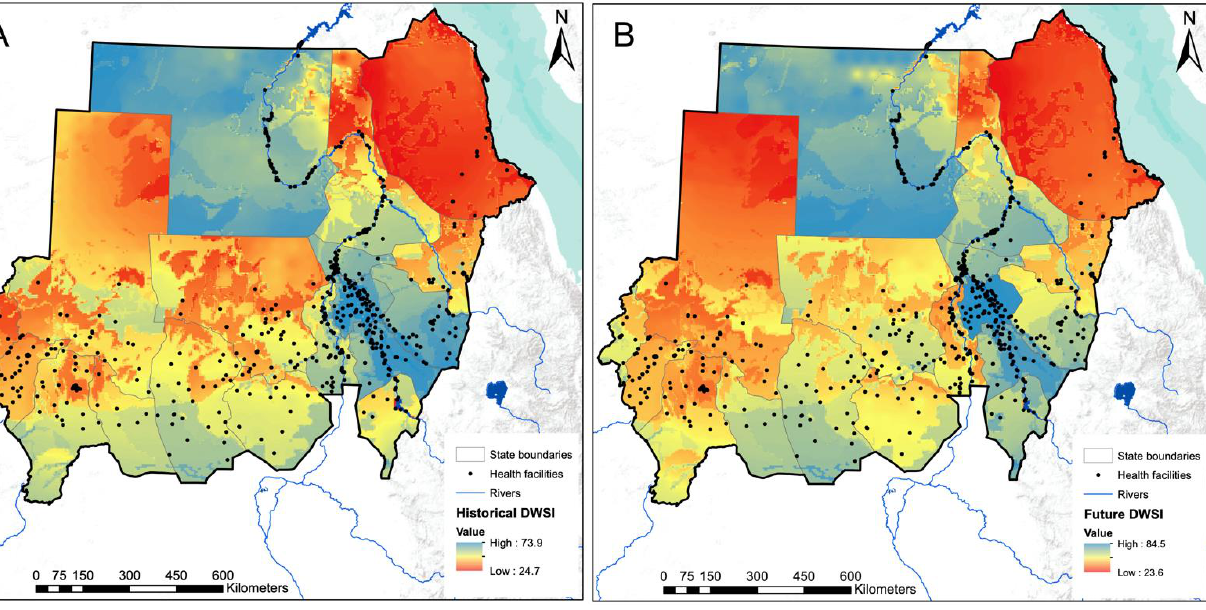
Figure 4. Assessment of the historical ( A ) and future ( B ) DWSI at a spatial resolution of 1 km